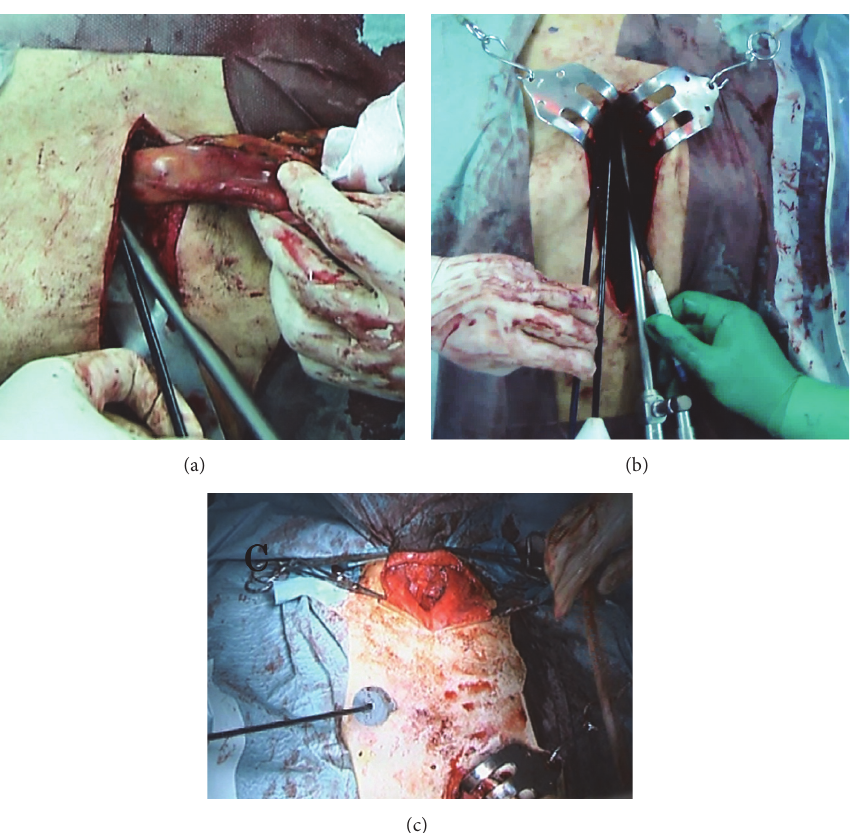
Figure 1: (a) Distal part of the gastric tube. (b) Endoscopic view of the dissection from the ventral side. (c) Neck incision and right chest thoracoscopic